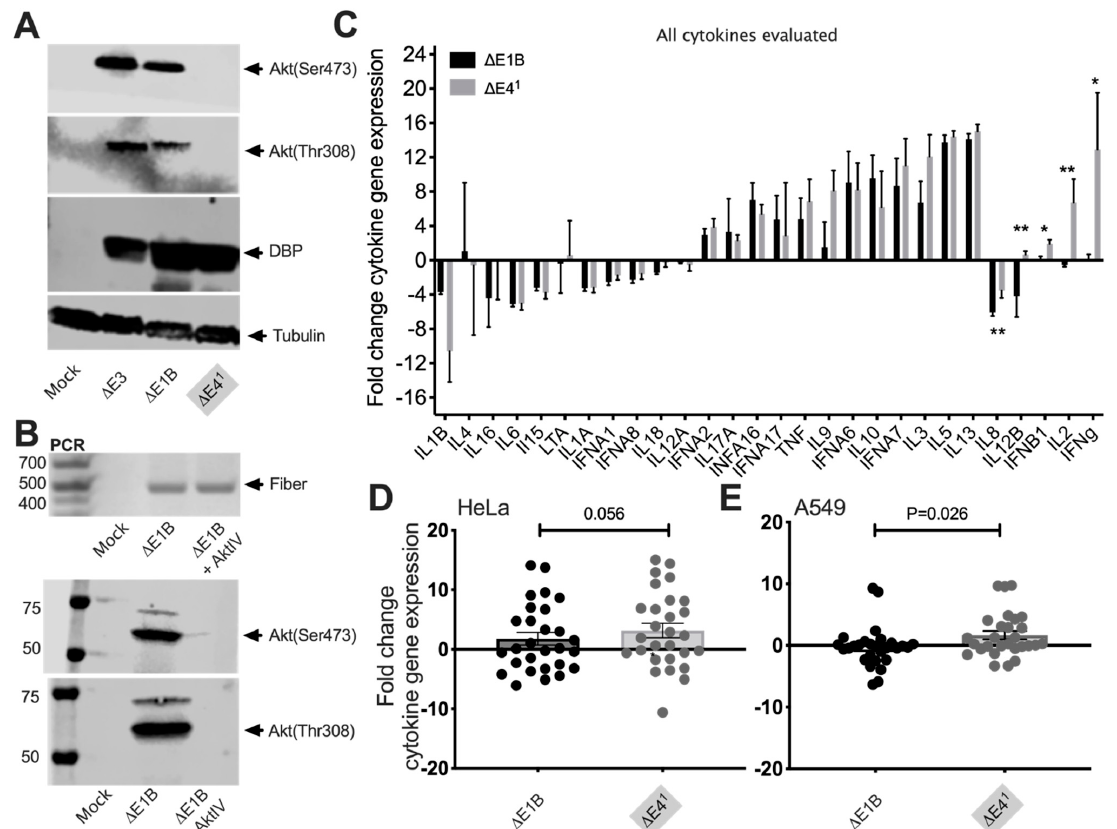
Figure 2. Effects of E4orf1 on innate cytokine gene expression in infected human epithelial cell lines. HeLa cells were infected at a MOI of 50 with Δ E3, Δ E1B and Δ E4 1 Ads and incubated for 48 h as described in Materials and Methods. ( A , B ) Western blotting using whole cell lysate shows the presence or absence of Akt phosphorylation at Ser473 and Thr308, with ( A ) Ad DNA binding protein (DBP) and ( B ) cells treated with or without AktIV. PCR for Ad fiber is used as the Ad infection control. ( C ) The fold change in expression levels of all the cytokines evaluated in HeLa cells are plotted. ( D , E ) The magnitudes of the induced/upregulated cytokines in each group are compared in ( D ) HeLa cells and ( E ) A549 cells. The differences in mean values are highlighted with colored boxes. For each cell line n = 2 biological repeats performed in triplicate. Mean plus SEM are plotted. p values obtained by Mann–Whitney unpaired t -test and Wilcoxon matched-pairs signed-rank test * = p < 0.05, ** = p <